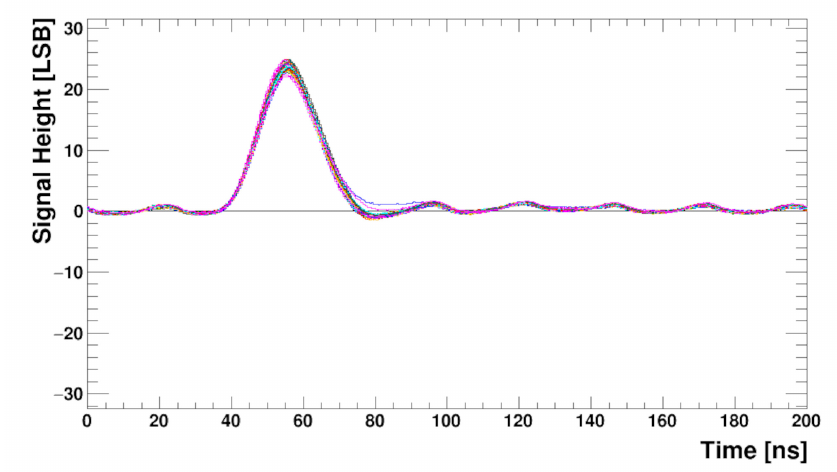
Figure 18. Pulse shapes for 128 channels obtained from the ADCs outputs after trim procedure applied, with a biased UT sensor connected.